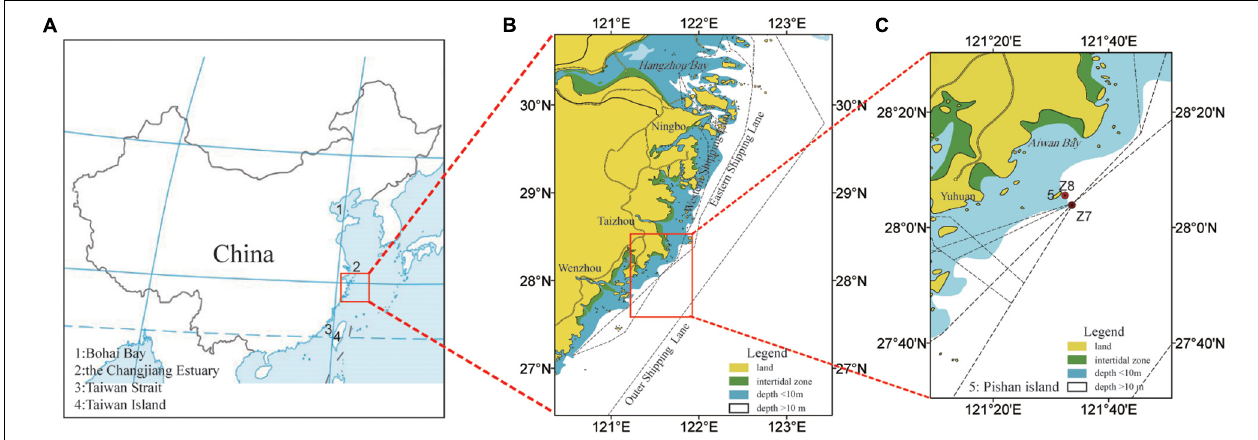
FIGURE 1 | Maps of the shipping lane indicate (A,B) the study area (according to He, 2008) and (C) the sampling site. Core Z7 was located at the intersection of the eastern and western shipping lane, and a control core (core Z8) was collected outside the shipping lane at a distance of 4.7 km northwest to core Z7.